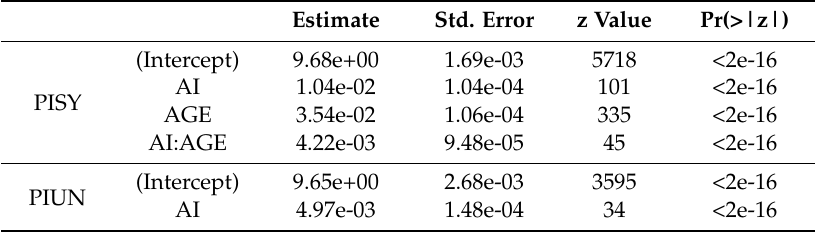
Table 2. Parameters of Basal Area Index models of the analyzed species. AI, AGE, and AI:AGE (interaction between the aridity index and the tree age).